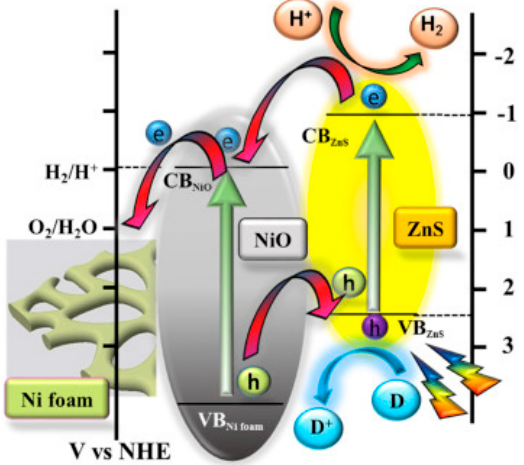
Figure 5. A possible mechanism for the photoexcitation and carrier transporting process of Ni-doped ZnS / NiO / Ni foam photocatalysts. Figure adapted from [70].